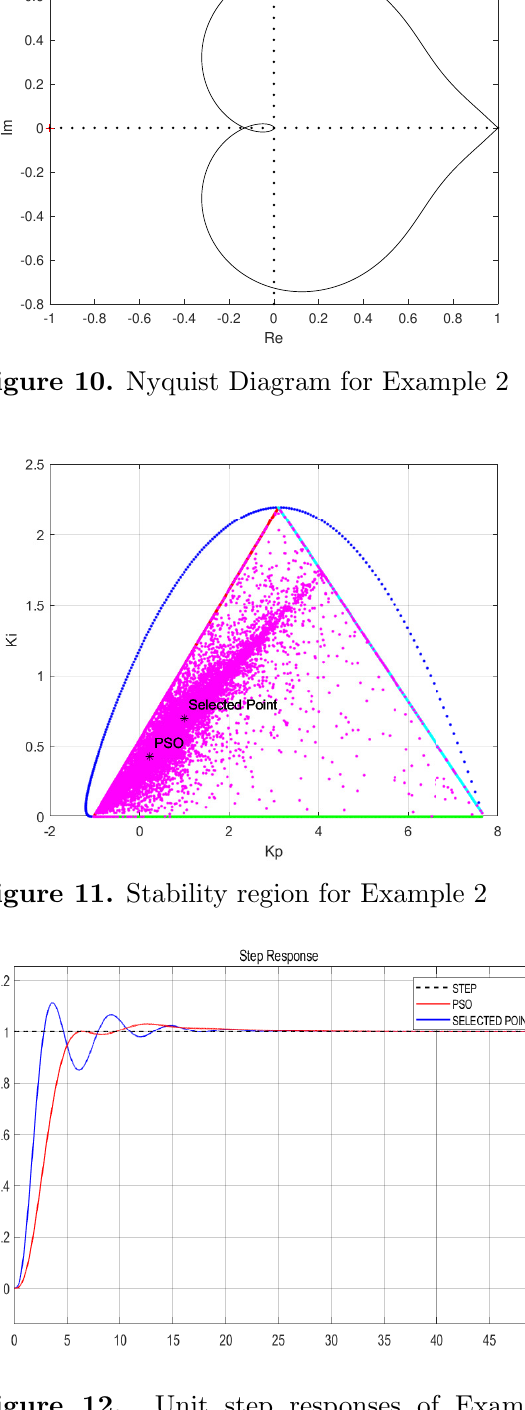
Figure 12. Unit step responses of Example 2 for k = 1 , k = 0 . 7 and PSO parameters p i k = 0 . 229 , k = 0 . p i